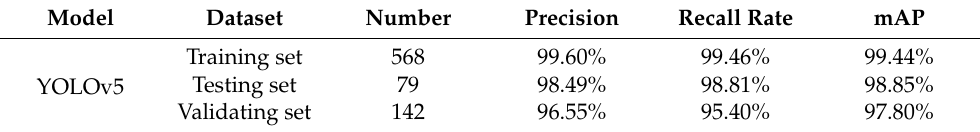
Table 2. The results of YOLOv5 for object detection on the training set, testing set, and validating set.